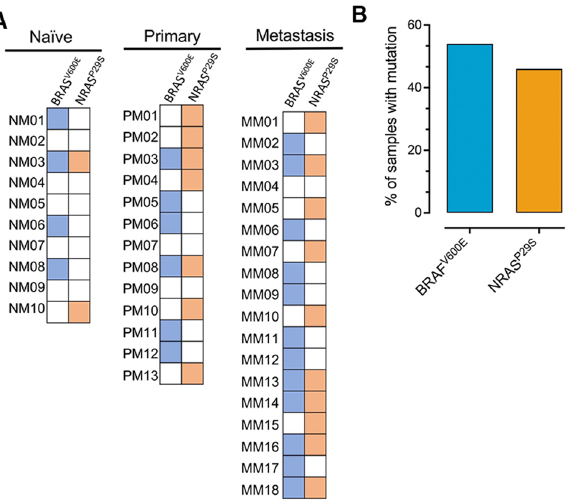
Figure 3. BRAF- and NRAS-mutant melanoma rates among different study groups. ( A ) Summary of the genetic landscape of BRAF V600E and NRAS P29S mutant genes in normal naïve/normal melanoma (n = 10), primary melanoma (n = 13) and metastasis melanoma (n = 18). ( B ) Bars represent the percentage of somatic BRAF V600E and NRAS P29S mutations, distinguished by their individual colors.